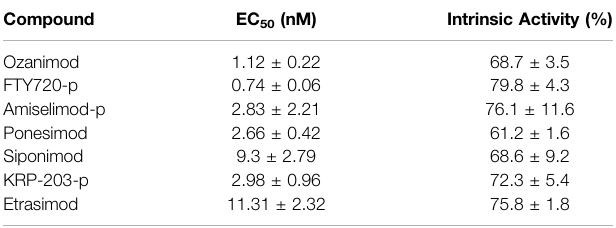
TABLE 3 | β -arrestin recruitment potency for human S1P 1 .